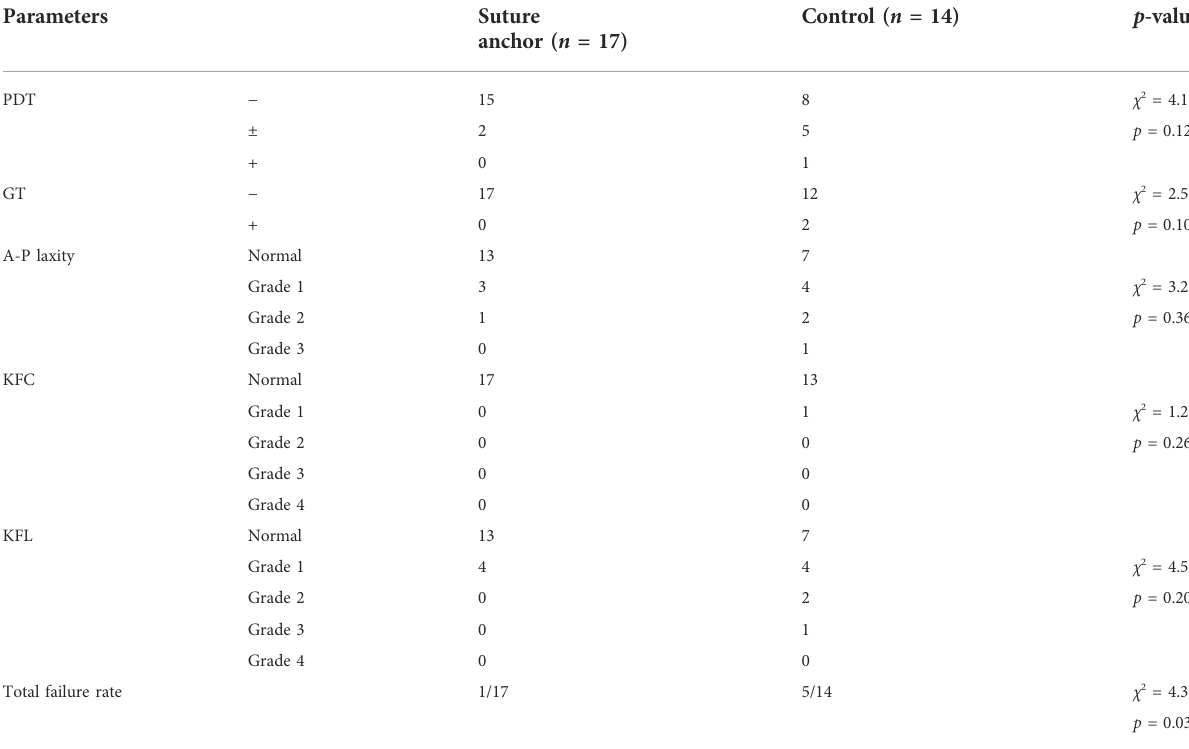
TABLE 2 The ef fi cacy of PCLAF patients in the bio-absorbable suture anchor and control groups at 1 year